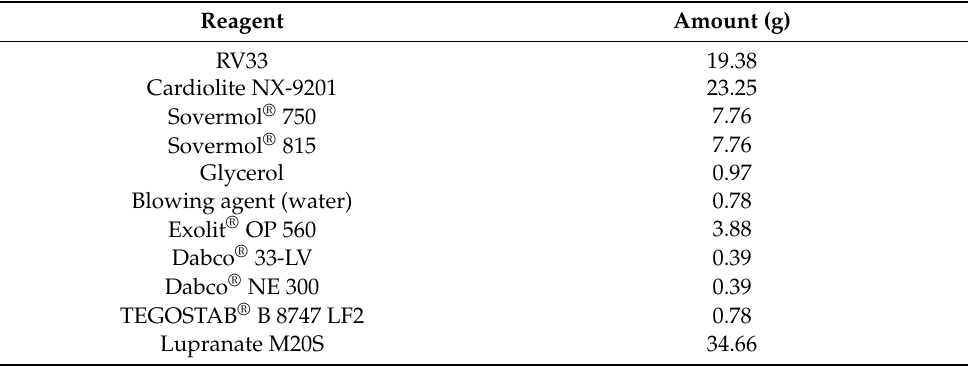
Table 2. Amount of reagents used in the PU foams